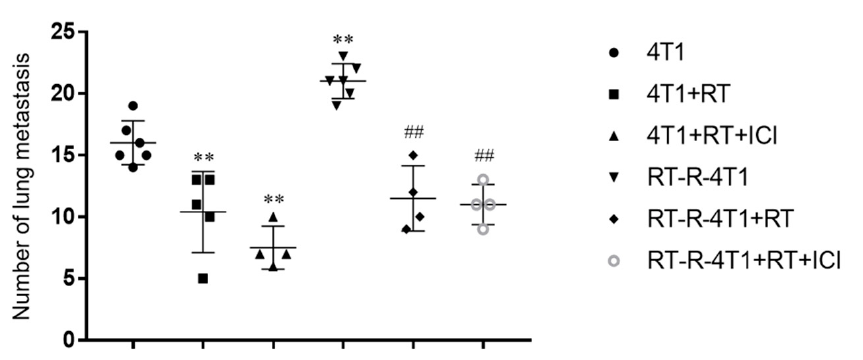
Figure 2. Combined PD-1 blockade therapy and RT reduced lung metastasis of breast tumor. Six- week-old female balb/c nude mice were injected as described above (n = 4–6). On day 21 after inoculation, the mice were sacrificed, and then the incidence of lung metastasis was measured. ** p < 0.01 compared to the 4T1-injected group; ## p < 0.01 compared to the RT-R-4T1-injected